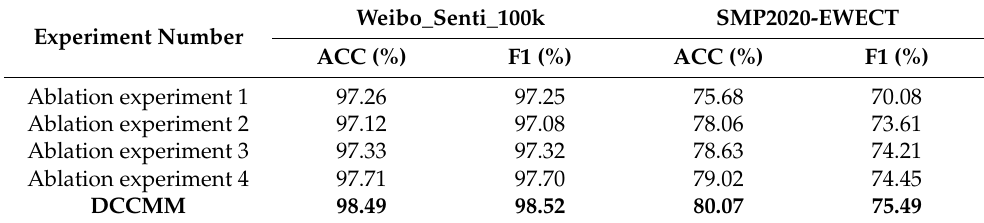
Table 6. Ablation experimental model performance